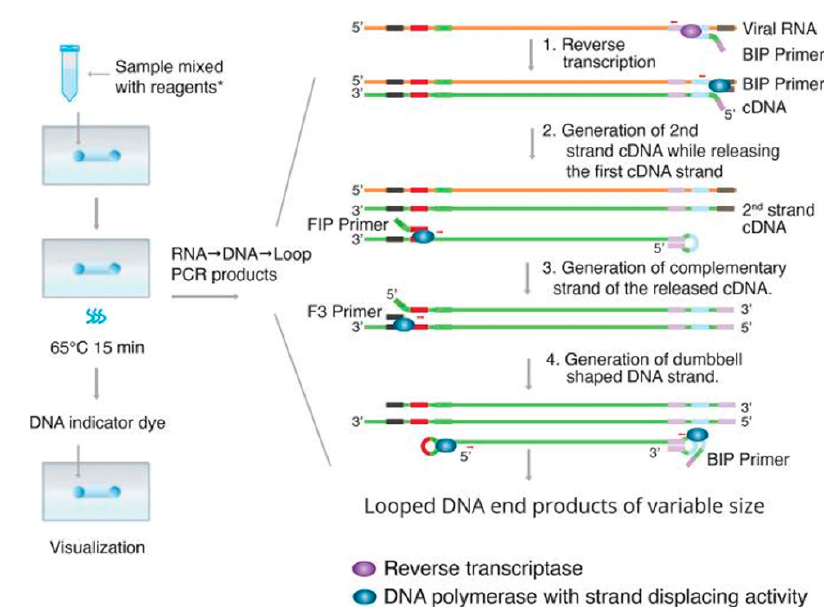
Figure 3. The main principle of the transcription loop mediated isothermal amplification (RT-LAMP) technique. RT-LAMP starts with the reverse transcription of the backward inner primmer (BIP). The BIP primer binds to the target sequence on the 3 ′ end of the RNA template and synthesizes a copy of the DNA strand (cDNA). Then, by using DNA polymerase, B3 primers bind to the side of the templates, generate the new cDNA strand, and release the first cDNA strand. This single strand of cDNA is then looped at the 3 ′ end and binds to itself. Next, the forward inner primmer (FIP) binds to the 5 ′ end of the strand and synthesizes a complementary strand by DNA polymerase. Then, the F3 primer binds to the end and generates a new double strand of DNA by DNA polymerase. The loop keeps running as a dumbbell-structure when the FIP or BIP primer initiates DNA synthesis again at the next target sequence location. The cycle can start at either the forward or backward side of the strand. When it starts, the strand undergoes self-primed DNA synthesis during the elongation stage of the amplification process. This amplification can be done in a short amount of time (approximately 1 h) and occurs at a constant temperature between 60–65 °C. Adapted by permission. Copyright of Linda C. et al. [66] .